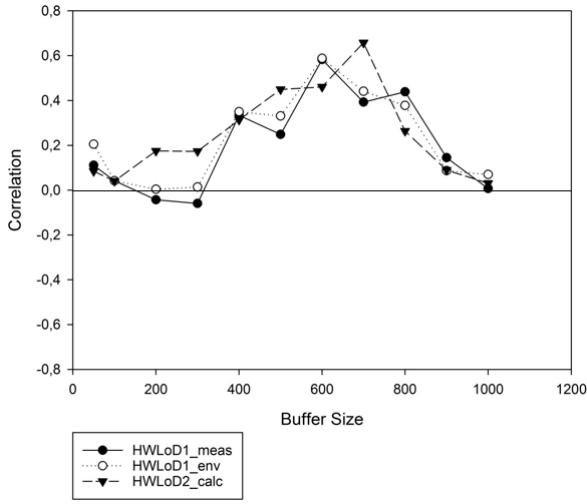
Figure 10. Correlation coefficients of the ‘height-width ratio’ from LoD1 with different measures and measured TNC values in different buffer sizes.